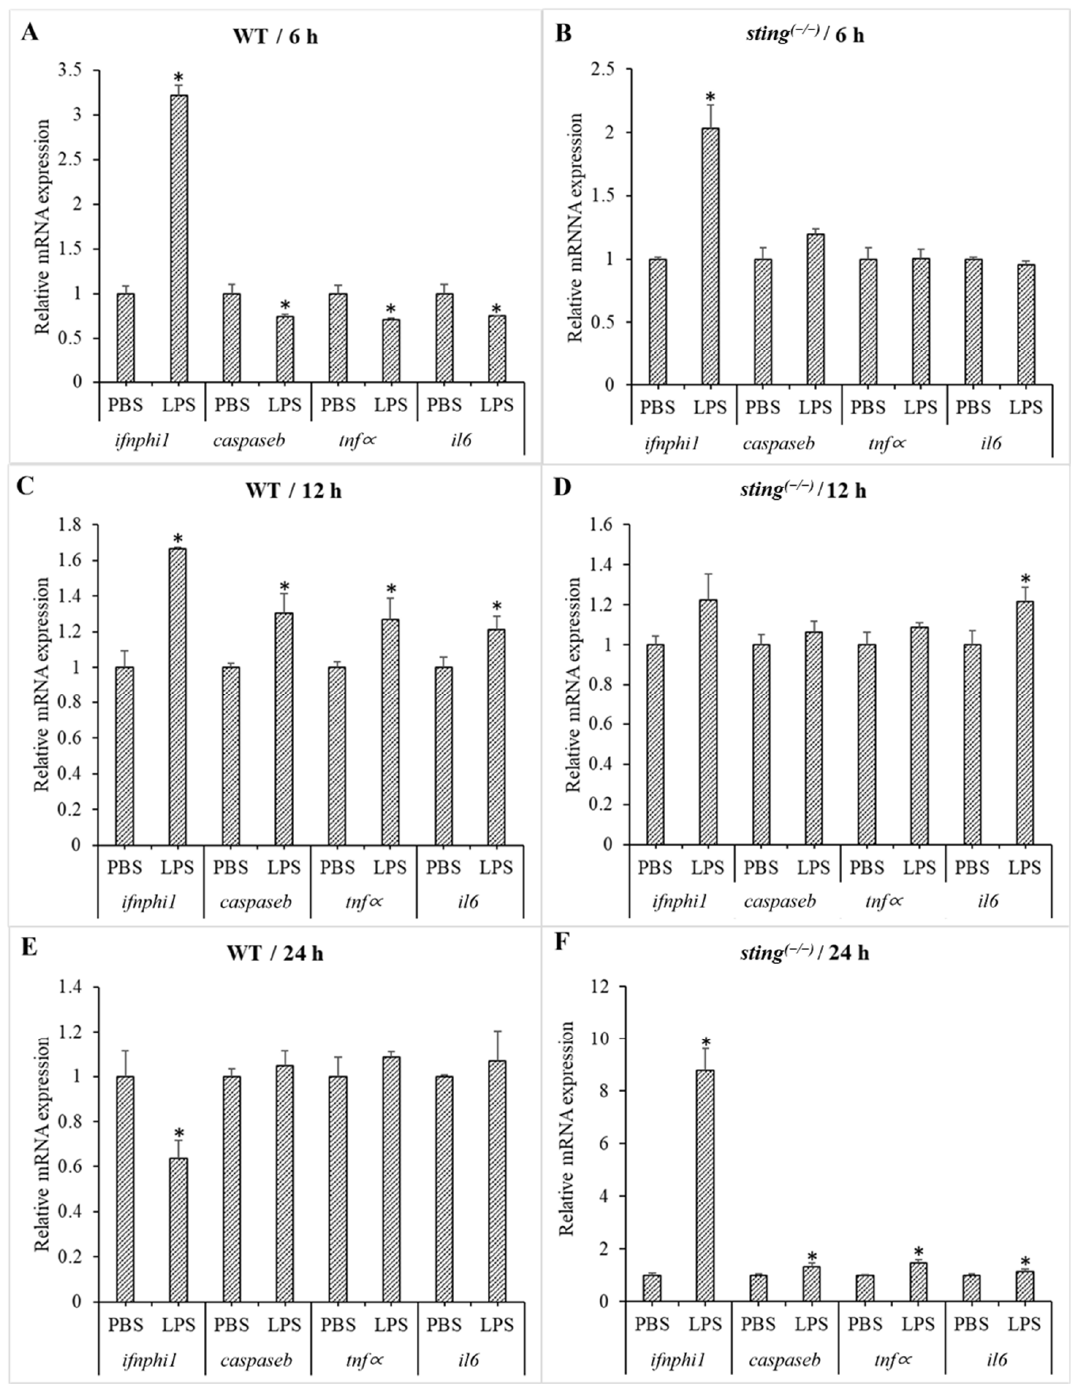
Figure 3. Comparison of gene expression in WT and sting ( − / − ) zebrafish larvae under LPS stimulation. The larvae samples were collected 6, 12, and 24 h post-LPS treatment of 3 dpf WT (( A , C , E ) respectively) and sting ( − / − ) (( B , D , F ) respectively) zebrafish larvae. Ef1 ∝ was used as an internal control to analyze the relative mRNA expression of genes downstream of sting using the Livak method. Transcription levels of target genes in the PBS-treated group were considered as 1, and expression levels in the LPS-treated groups were normalized to those in the PBS-treated group and are represented as fold values. Standard deviation (SD; n = 3) is indicated by the error bars. Significantly differentially transcribed genes (when compared to the respective PBS- treated control) are marked with an asterisk (*: p < 0.05).